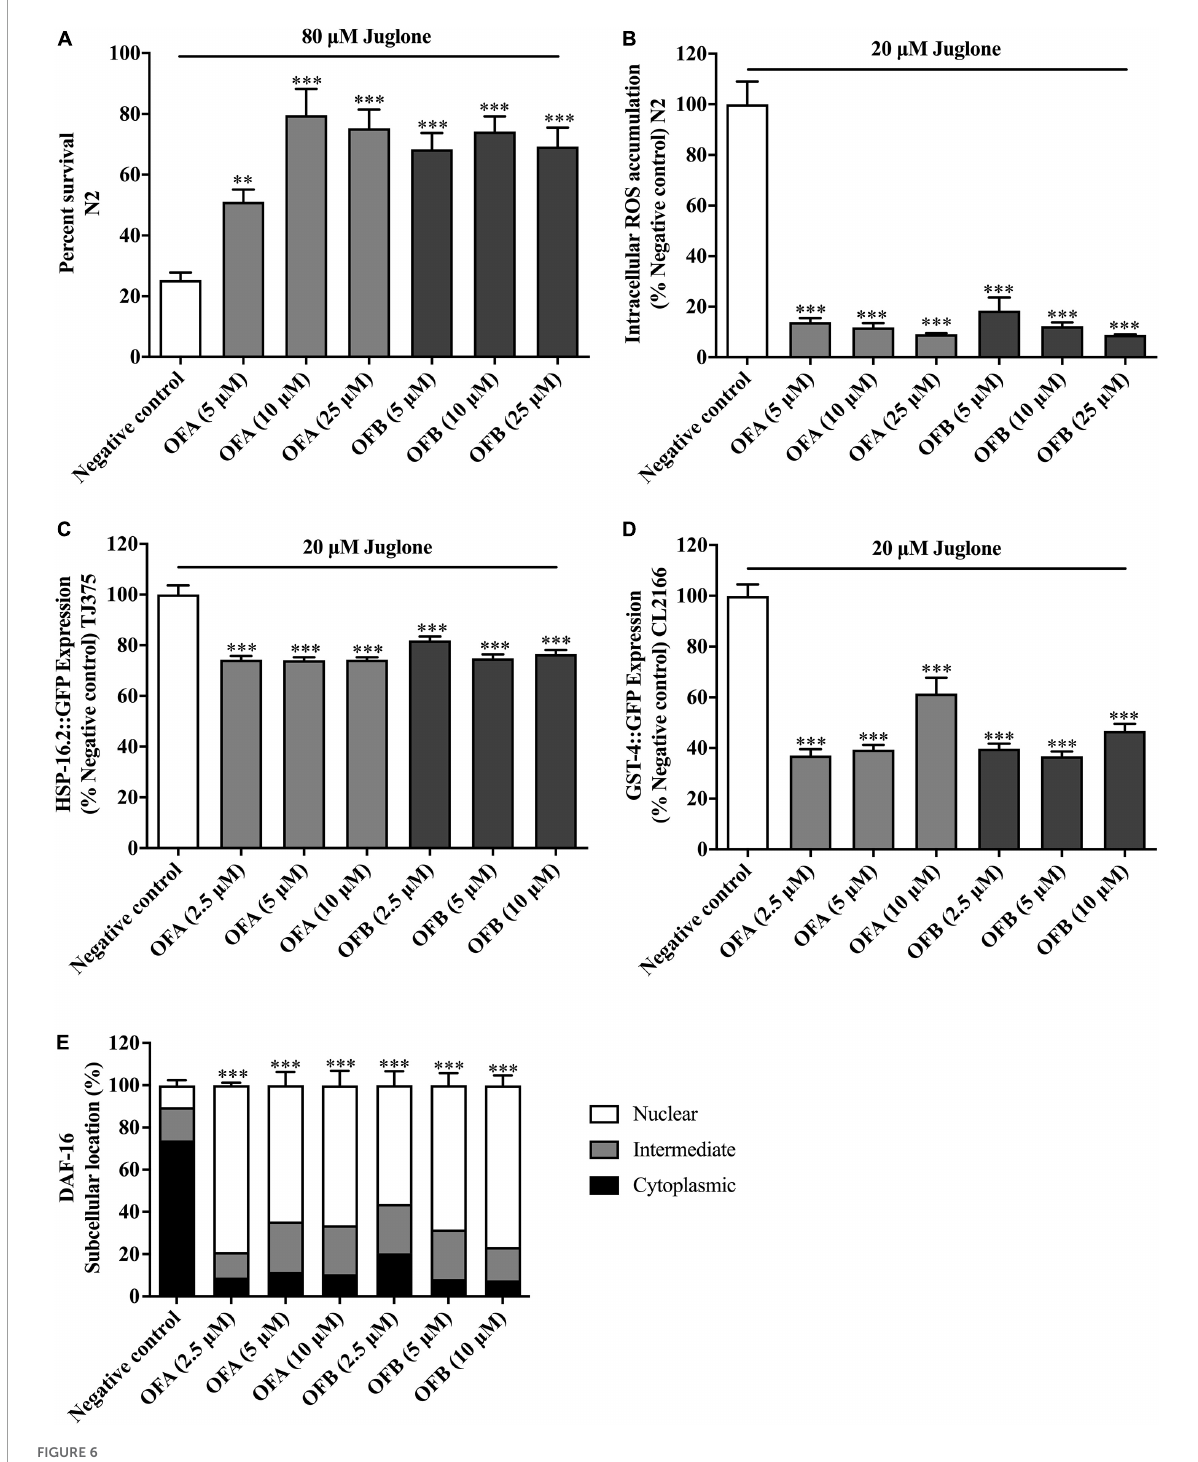
FIGURE6 Effect of OFA and OFB on C. elegans under oxidative stress condition treated with juglone. Percent survival of wild-type (N2) treated with OFA and OFB under lethal juglone concentration (80 µ M) condition (A) . OFA and OFB attenuate intracellular ROS accumulation in wild-type (N2) under 20 µ M juglone condition (B) . Effects of OFA and OFB on the expression of hsp-16.2 (C) and gst-4 (D) under 20 µ M juglone condition. The localization of DAF-16 transcription factors (E) . All data are shown as the mean ± standard deviation ( n ≥ 3 independent experiments). ∗∗ p < 0.01, ∗∗∗ p < 0.001 compared to the negative